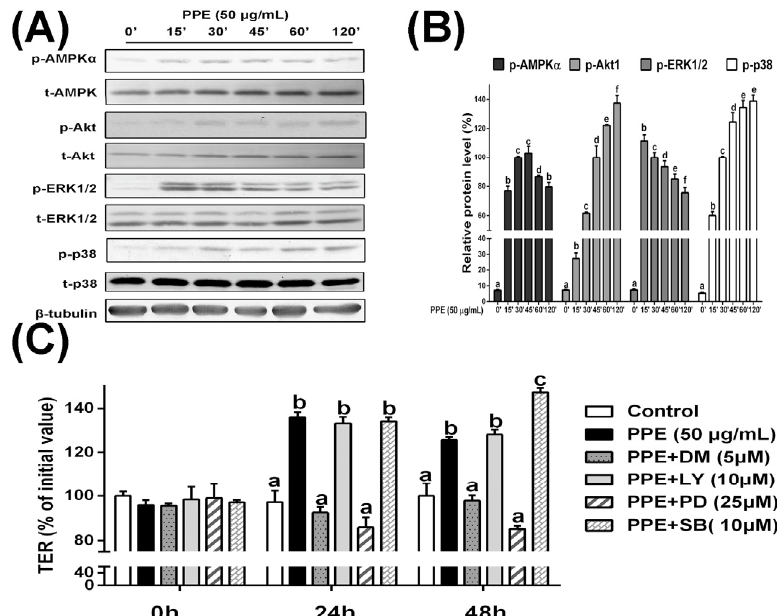
Figure 3. PPE treatment activates AMPK and ERK signaling in Caco ‐ 2 cell monolayers and selective inhibitors block PPE ‐ induced TJ regulation. ( A ) Caco ‐ 2 cells were grown to confluence on six ‐ well plates and treated with PPE (50 μ g/mL) for the indicated periods. Whole cell lysates were collected and further subjected to an immunoblot analysis. Selective antibodies were used to detect the expression of phospho ‐ AMPK α , total ‐ AMPK, phospho ‐ Akt, total ‐ Akt, phospho ‐ ERK1/2, total ‐ ERK1/2, phospho ‐ p38, and total ‐ p38. β‐ Tubulin was used as a loading control. Representative Western blots are shown from three independent experiments; ( B ) The intensity of corresponding bands was measured by densitometry and normalized to β‐ tubulin. The values are the means ± SD ( n = 3). Means sharing the same letter are not significantly different from each other ( p < 0.05); ( C ) Caco ‐ 2 cell monolayers were grown on 12 ‐ Costar Transwell filters for 14 days. Cells were pretreated for 1 h with selective inhibitors: 5 μ M DM (Dorsomorphin, for AMPK signaling), 10 μ M LY (LY294002, for Akt signaling), 25 μ M PD (PD98059, for ERK1/2 signaling), and 10 μ M SB (SB203580, for p38 signaling) before treatment with PPE (50 μ g/mL) for 24 h or 48 h. The change in TER is expressed as the percentage change compared to the initial TER for each monolayer. The values are the means ± SD ( n = 3). Means sharing the same letter are not significantly different from each other ( p < 0.05).